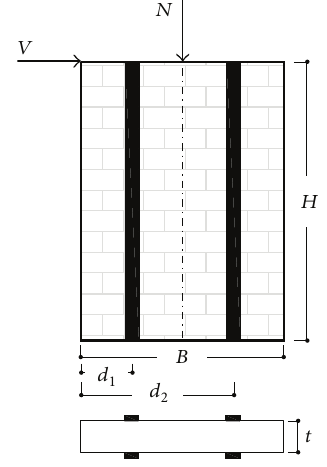
Figure 4: Strengthening configuration of the